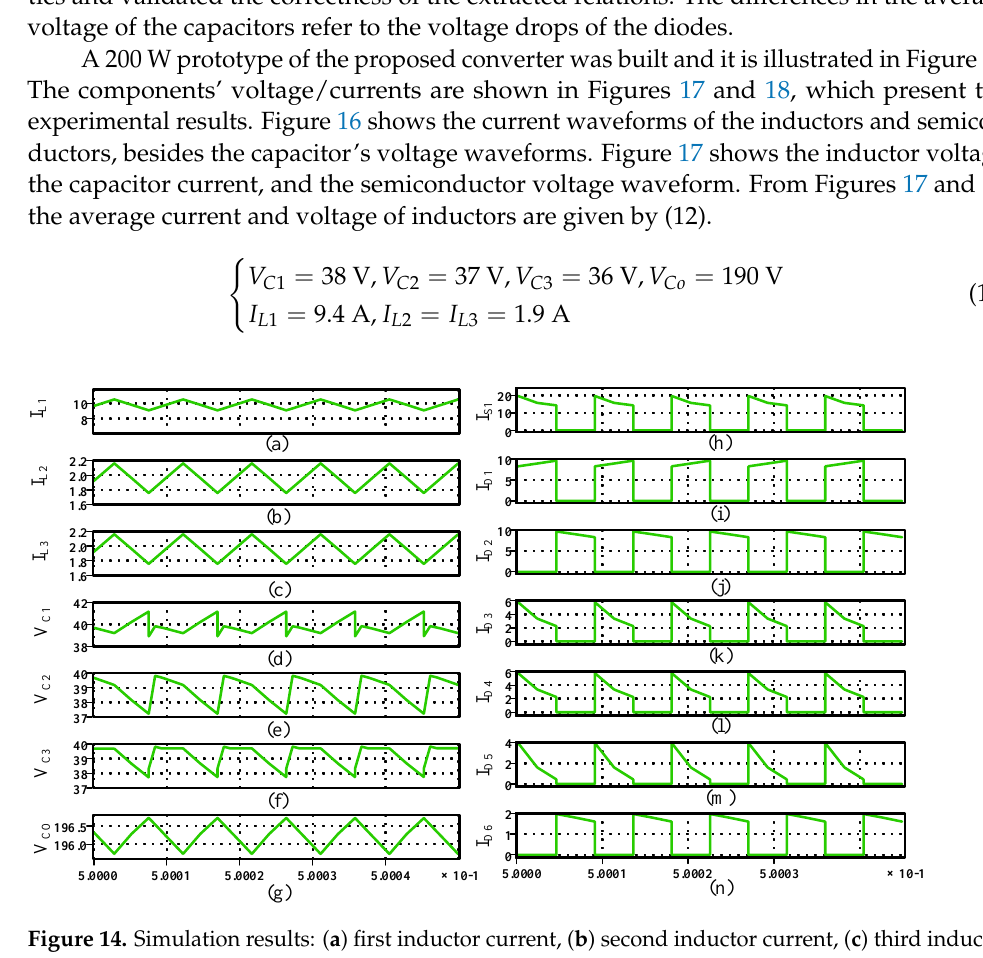
Figure 14. Simulation results: ( a ) first inductor current, ( b ) second inductor current, ( c ) third inductor current, ( d ) first capacitor voltage, ( e ) second capacitor voltage, ( f ) third capacitor voltage, ( g ) output capacitor voltage, ( h ) switch current, ( i ) first diode current, ( j ) second diode current, ( k ) third diode current, ( l ) fourth diode current, ( m ) fifth diode current, ( n ) sixth diode